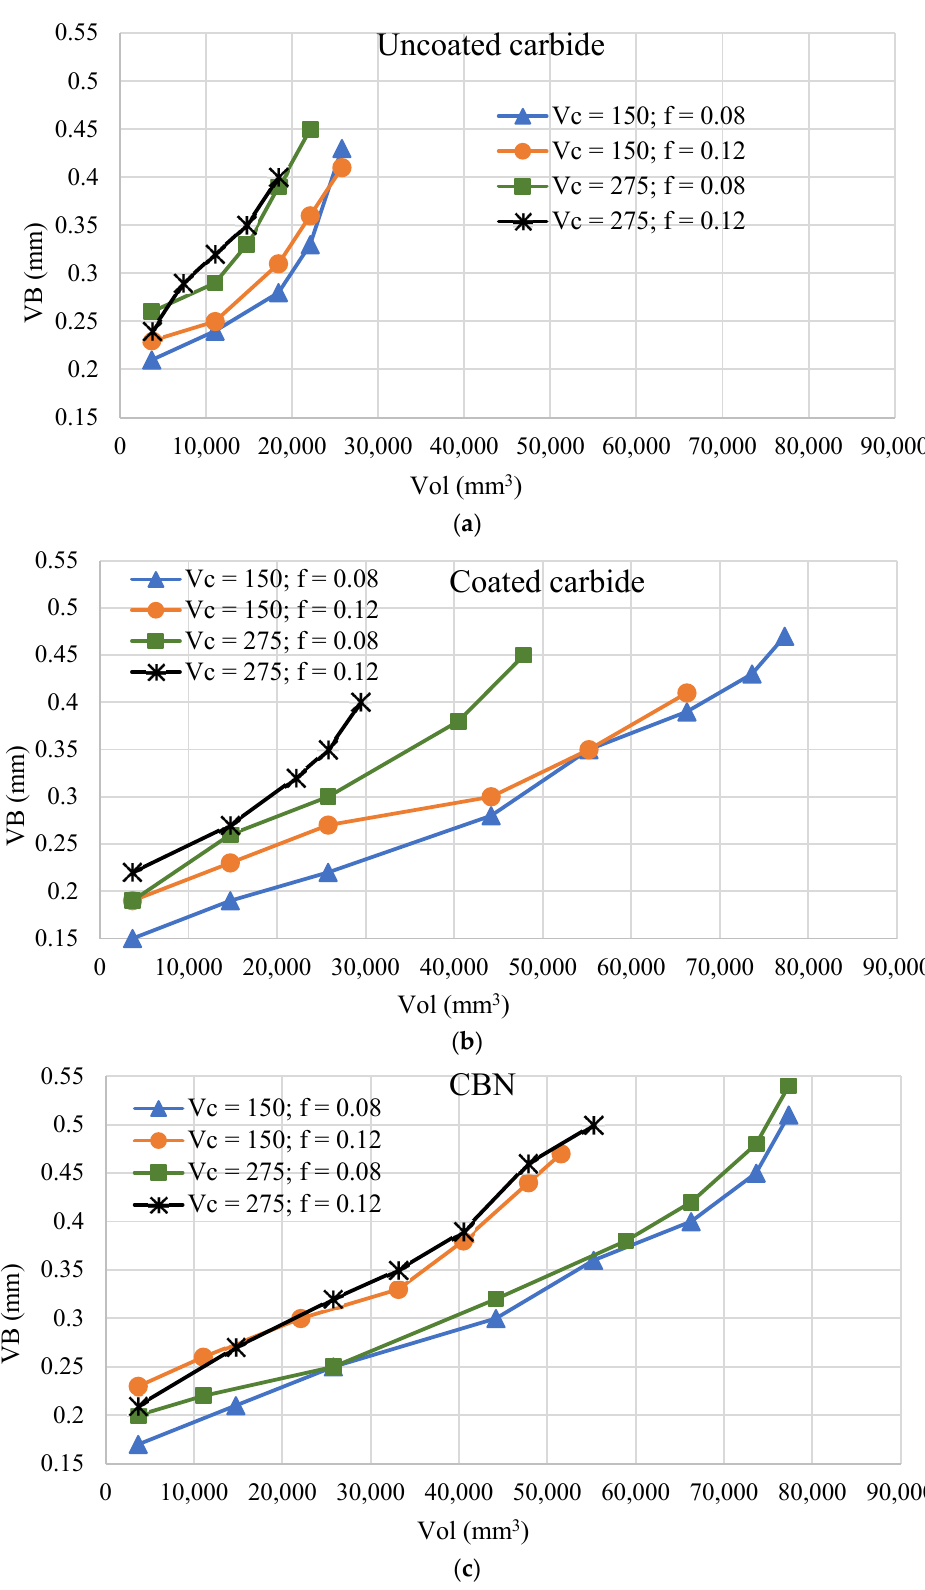
Figure 2. Progress of tool’s flank wear with volume of work material removed, categorized with respect to the three cutting inserts used in the experiments: ( a ) uncoated carbide; ( b ) coated carbide; and ( c ) CBN. V c and f are represented in m/min and mm/rev, respectively.